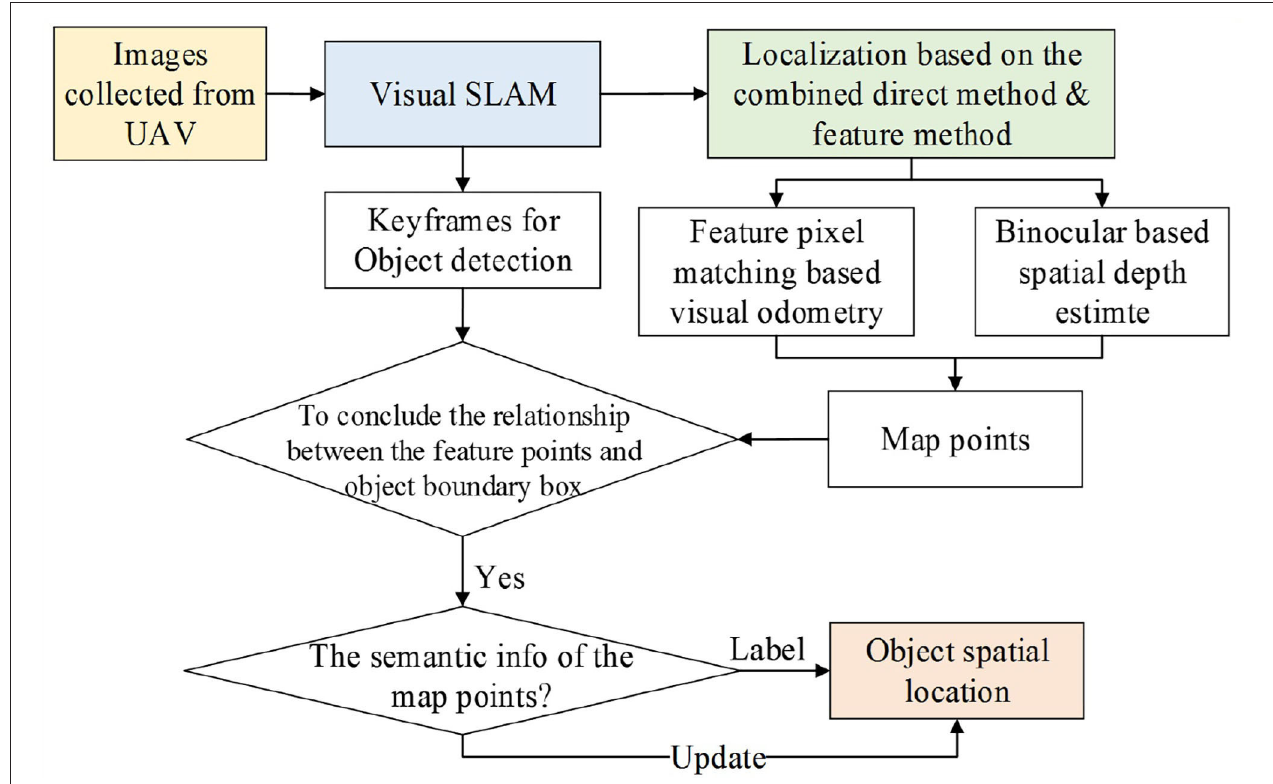
FIGURE 1 | The procedure of the proposed